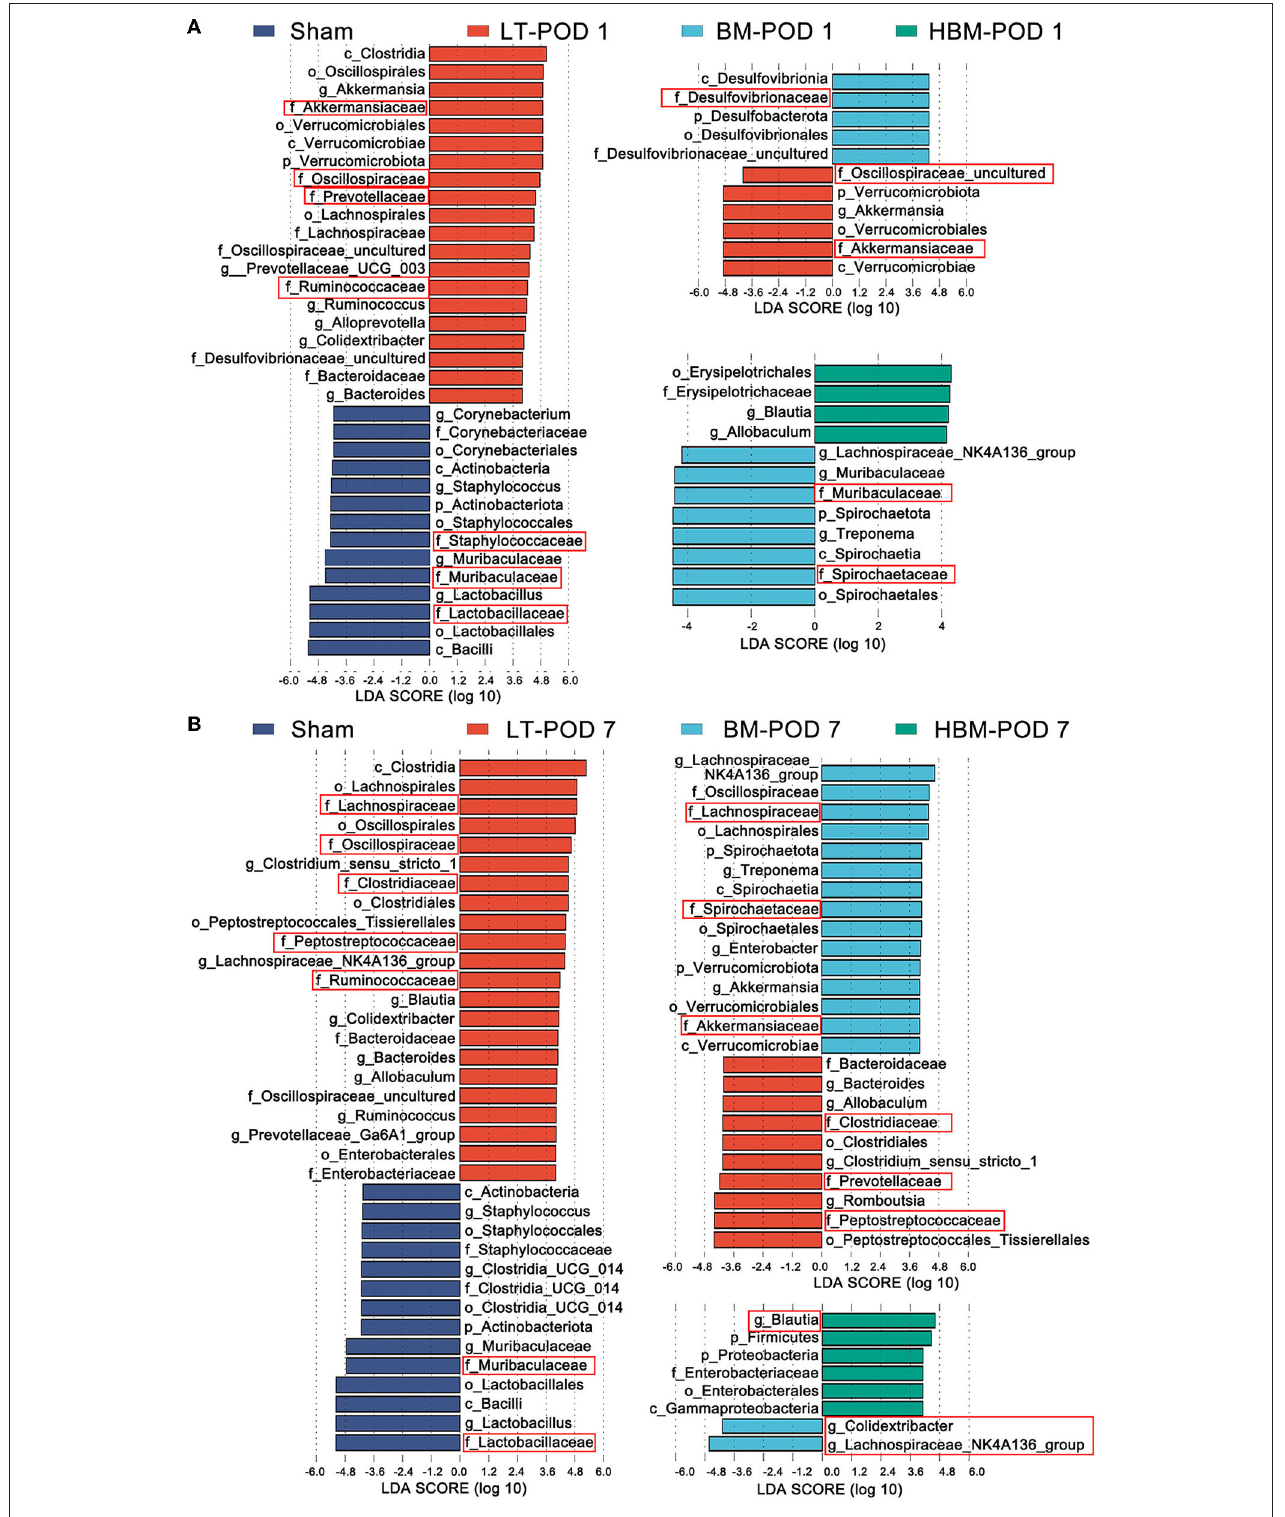
FIGURE 6 | (A) Species abundances of different species between groups in the Lefse analysis on POD 1; the red box shows the microbiota with obvious differences at the family level. (B) Lefse analysis of the histogram of the abundance of different species among the groups on POD 7; the red box shows the flora with obvious differences at the family